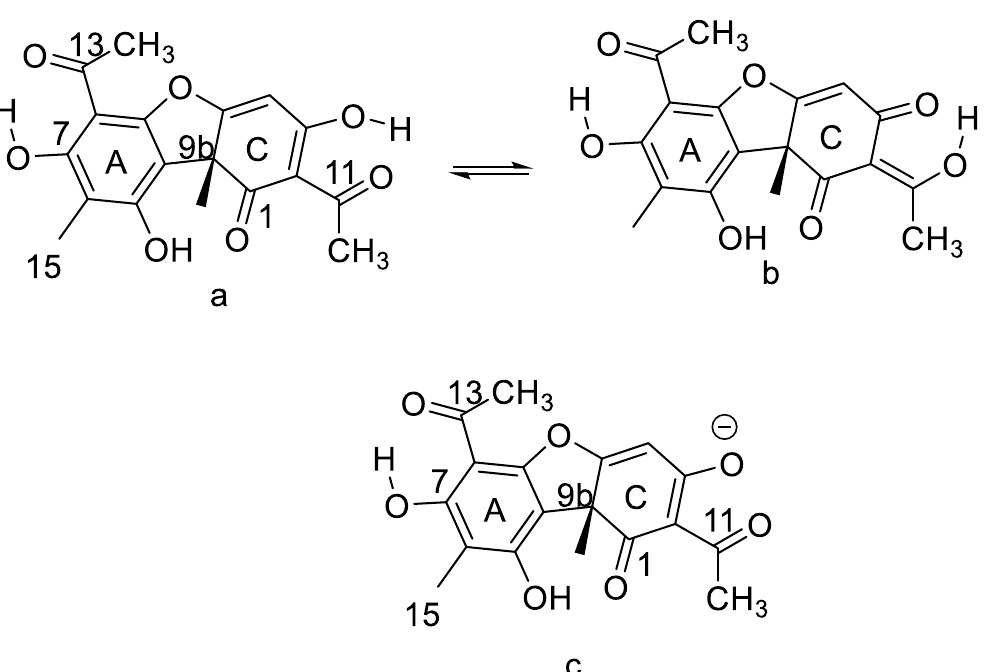
Figure 14. Tautomeric structures of usnic acid ( a , b ) ( top ) and the anion ( c ) ( bottom ).